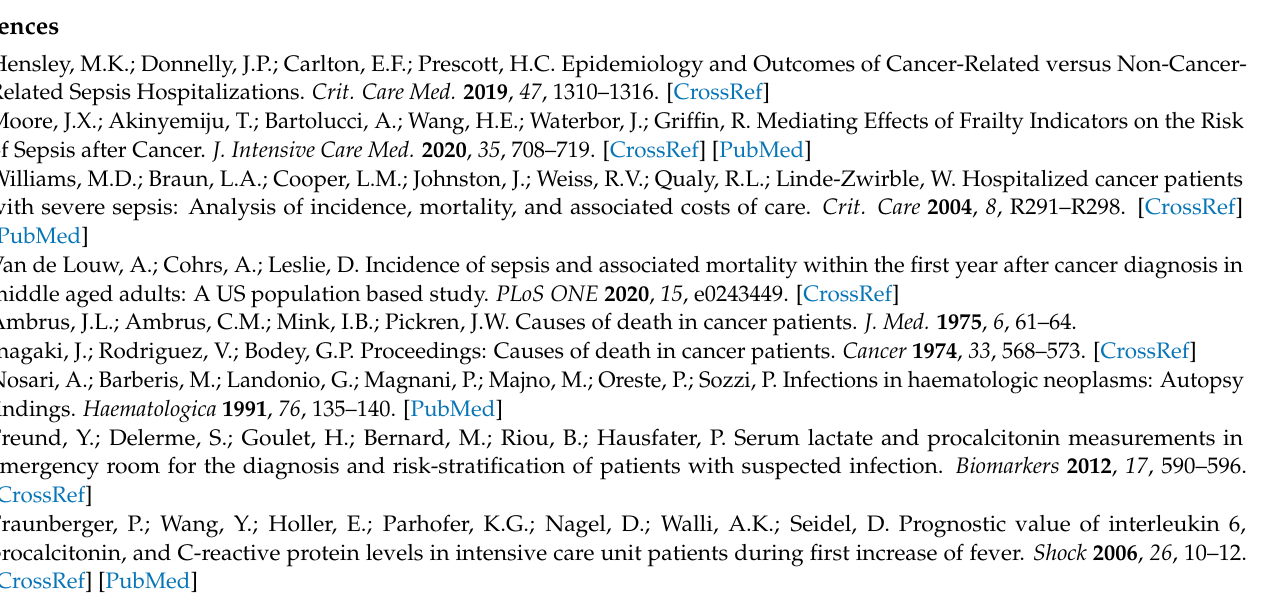
K-fold cross-validation accuracy of the final prediction model (K = 10), Figure S7. Association of final risk group with 3-month survival. Table S1: Fourteen-day mortality by quick sequential organ failure assessment (qSOFA) score for emergency department (ED) visits ( n = 5118), Table S2: Variation of infection biomarkers by quick sequential organ failure assessment (qSOFA) score, Table S3: Variation of infection biomarkers by blood culture result, Table S4: Cancer type risk stratification, Table S5: Fourteen-day mortality rates stratified by prediction score, Table S6: Fourteen-day mortality rates stratified by prediction score risk group, Table S7: Thirty-day mortality and intensive care unit (ICU) admission rates stratified by prediction score risk group, Table S8: Univariate and multivariable Cox proportional hazards model analysis of three months survival for different final risk